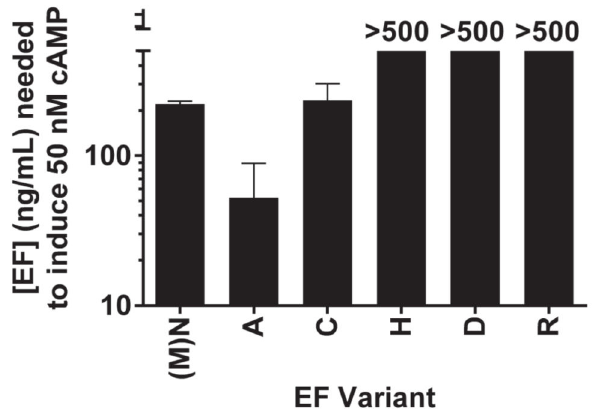
Figure 2. Production of cAMP by purified EF N-terminal variants in RAW264.7